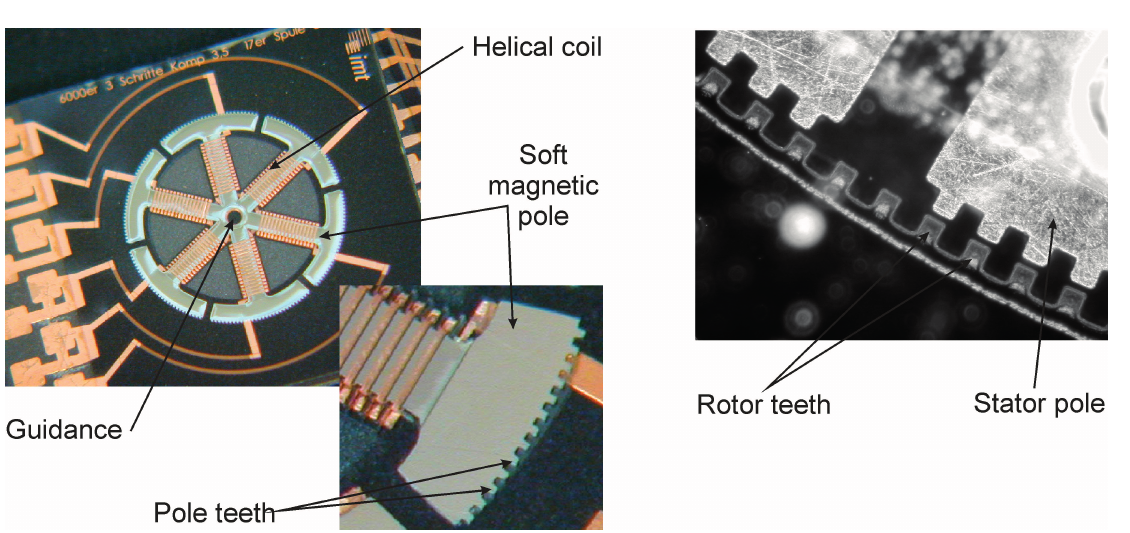
Figure 4. Rotatory VR stepper motor configuration: ( left ) Stator; ( right ) External